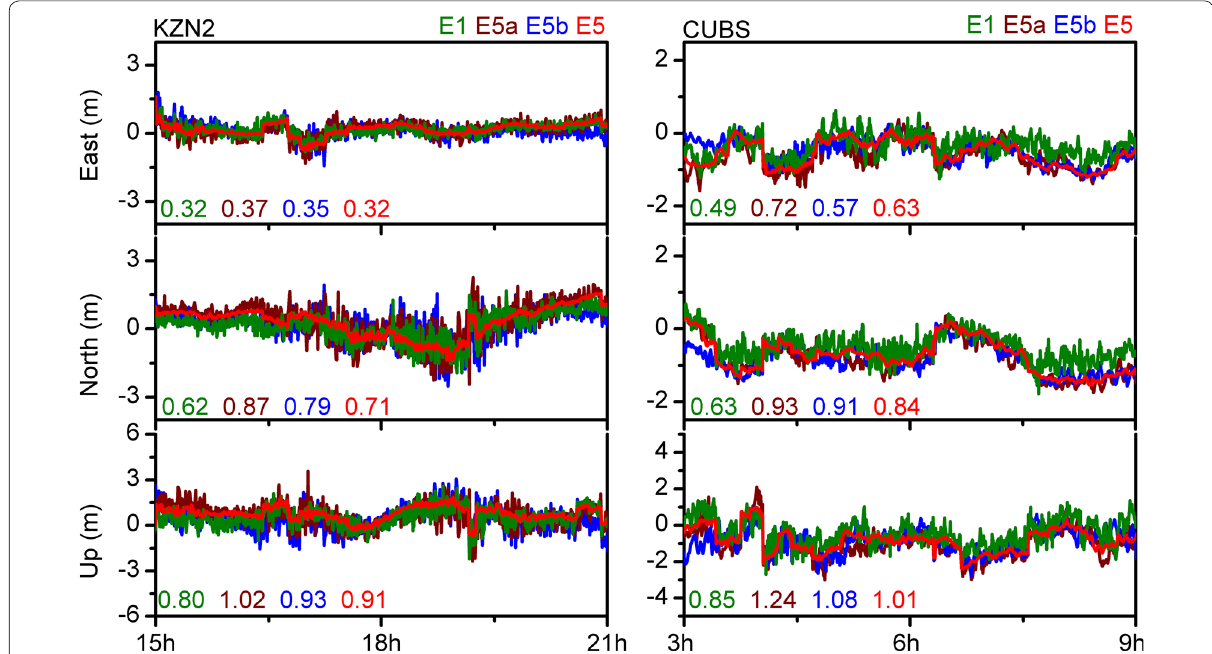
Fig. 12 Epoch-wise positioning errors of E1/E5a/E5b/E5 for stations KZN2 ( left ) and CUBS ( right ) on DOY 200 of 2018. RMS values (unit: m) for different signals are shown with different colors